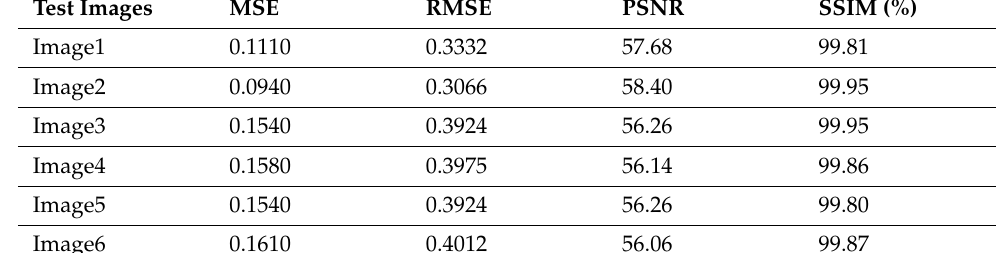
Figure 3. ROI Extraction.